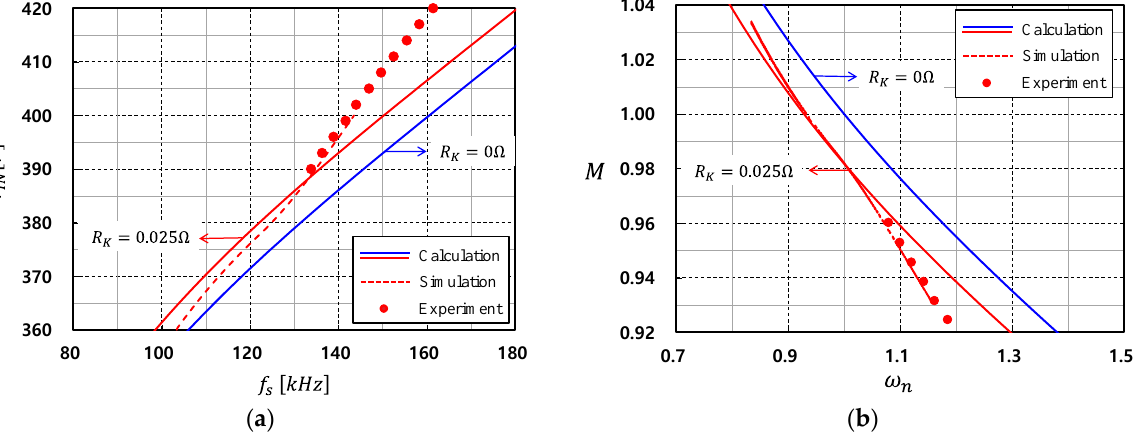
Figure 20. Frequency characteristics of DC voltage gain M at high load current: ( a ) Input voltage characteristics in accordance with switching frequency variation; and ( b ) DC voltage gain M characteristic in accordance with normalized frequency variation.